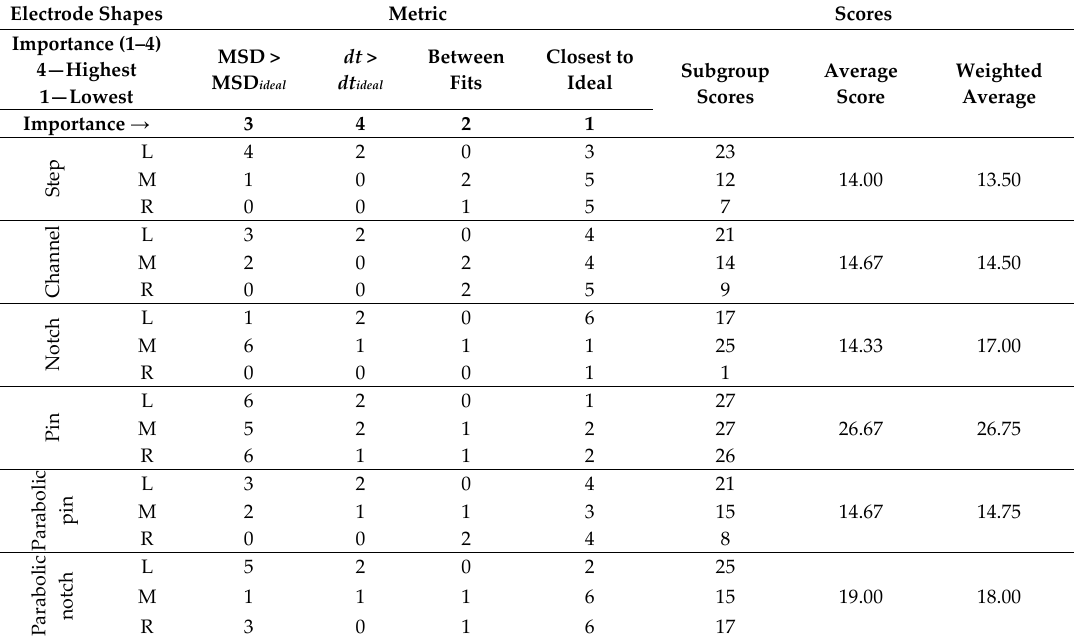
Table 4. Comparative evaluation matrix of the electrode shapes’ MSD analysis.